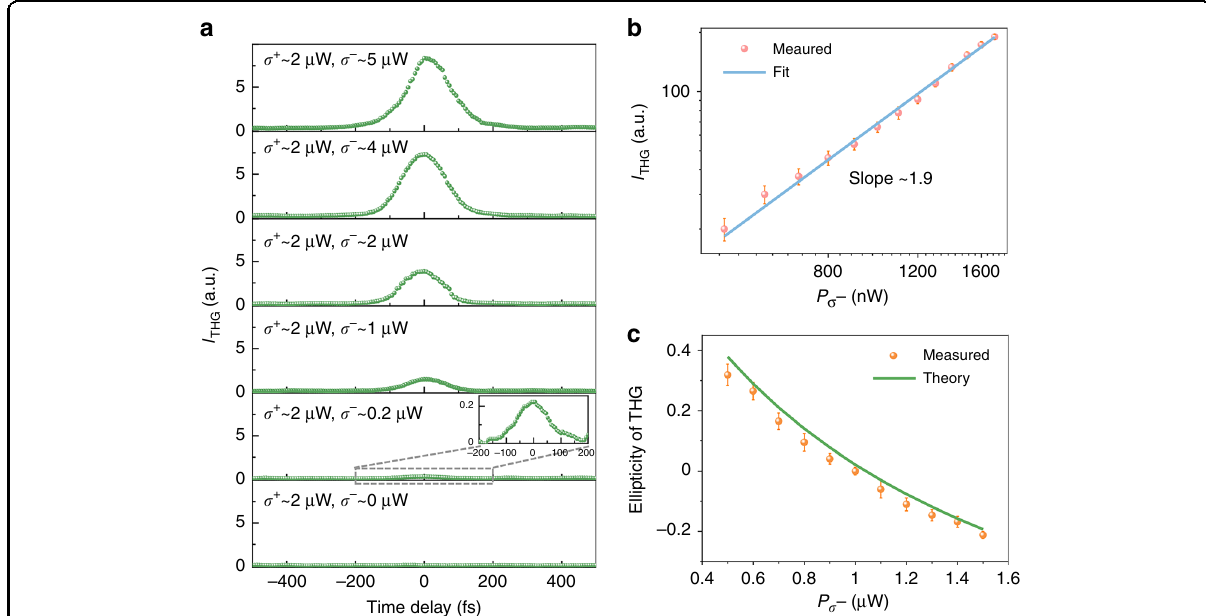
Fig. 3 Modulated THG in monolayer MoS 2 with two circularly polarized beams (Case 1). a Modulated THG signal as a function of the time delay under different incident powers. b , c Modulated THG ’ s power and ellipticity dependence on the σ − circularly polarized incident beam power while the power of the σ + circularly polarized beam is fi xed at ~1 μ W. Note that the measured average power of the incident beam is proportional to m 2